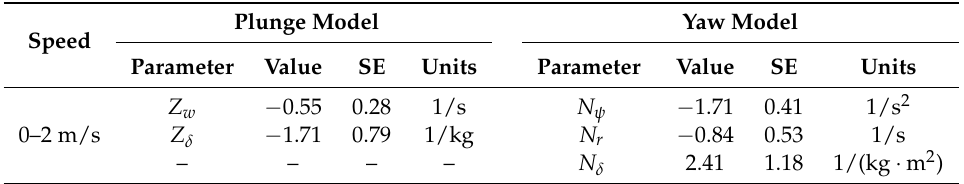
Table 4. Nominal plunge and yaw model parameter estimates.